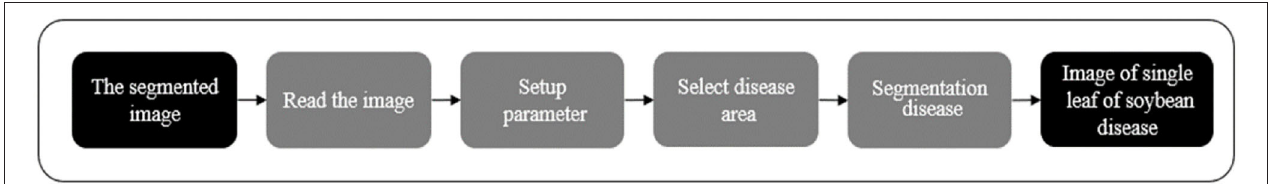
FIGURE 7 | Flow chart of region labeling.